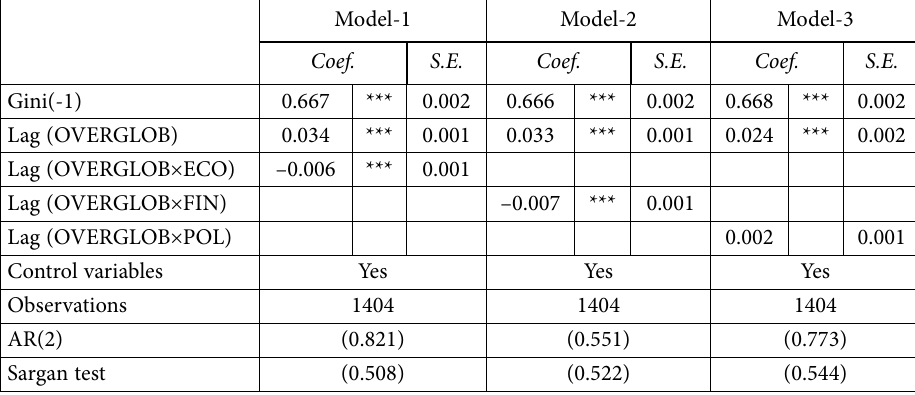
Table A7. The effects of globalization under different country risks (lagged model) Model-1 Model-2